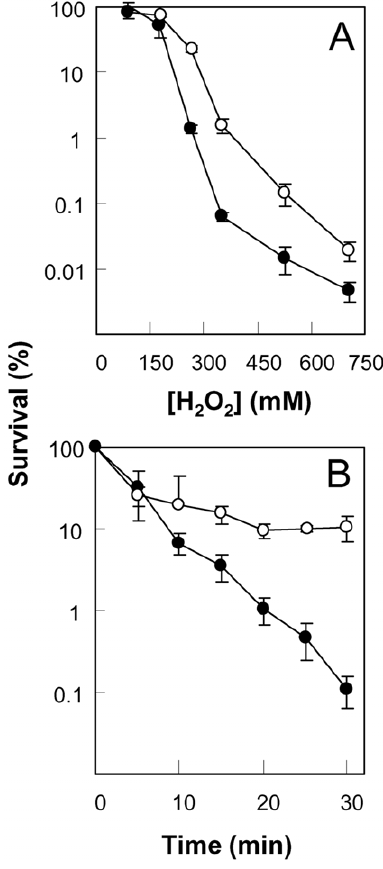
Figure 2. Effect of ndoA deficiency on bacterial survival after treatment with hydrogen peroxide. Wild-type strain (BD630, filled circles) and its D ndoA mutant (3169, open circles) were treated with the indicated concentrations of hydrogen peroxide for 15 min (panel A) or for the indicated times at 250 mM (panel B). Error bars indicate standard deviation; similar results were obtained in replicate experiments.